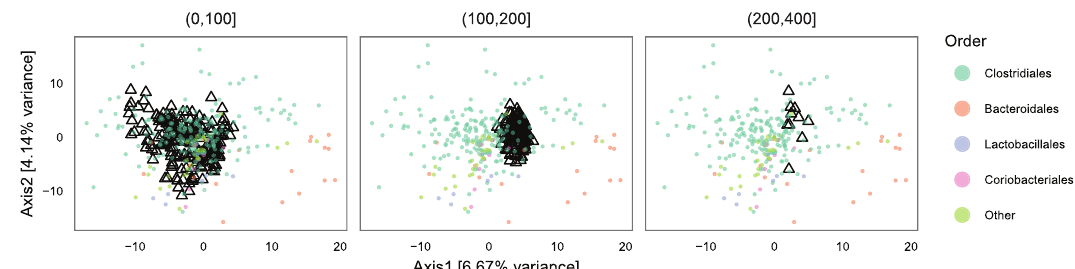
Figure 16. The biplot resulting from the PCA after the truncated-ranking